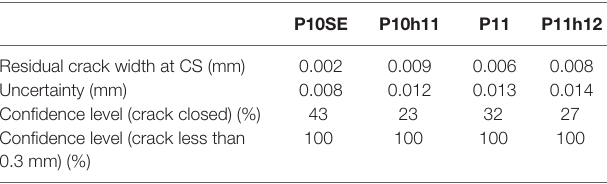
tABLe 1 | Confidence levels for significance of residual cracks in the southeast leg of streicker Bridge (Abdel-Jaber and Glisic,